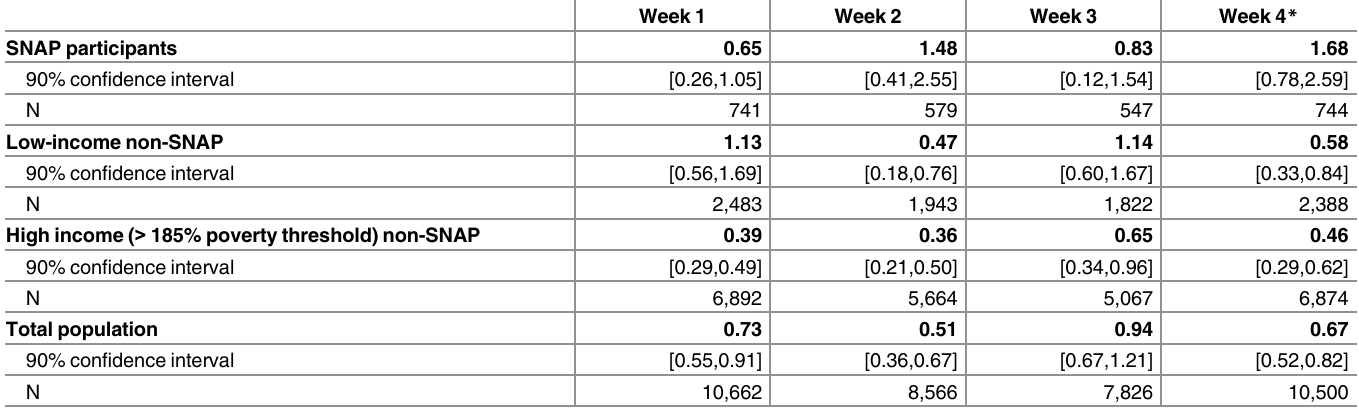
Table 1. Percent of group that reported no primary eating/drinking or secondary eating on an average day, 2006 – 08, age 15 and over, by week since SNAP